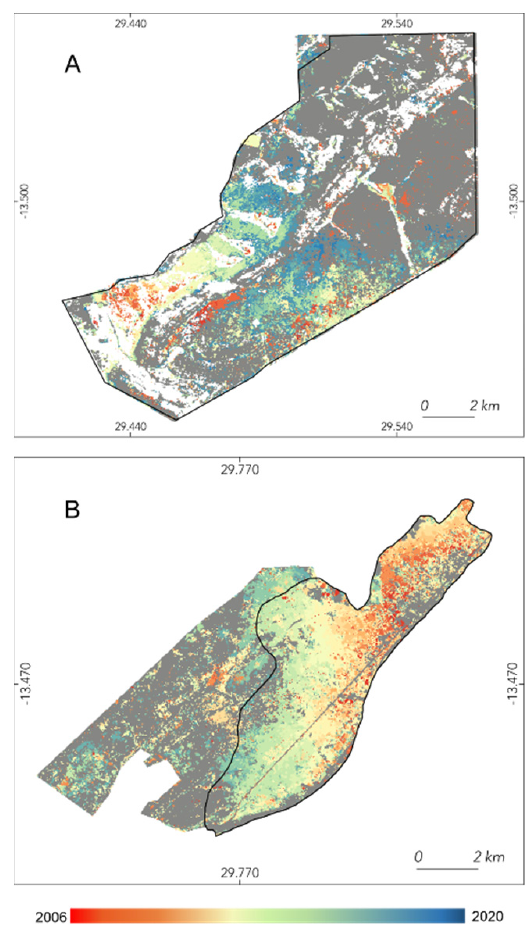
Figure 6. Evolution of annual forest degradation extent in Mkushi forest reserve from 2006 to 2020 based on change analysis of multitemporal Landsat 5 and 8 imagery. ( A ) Sector 1; ( B ) Sector 2. Grey areas represent remaining tree cover.